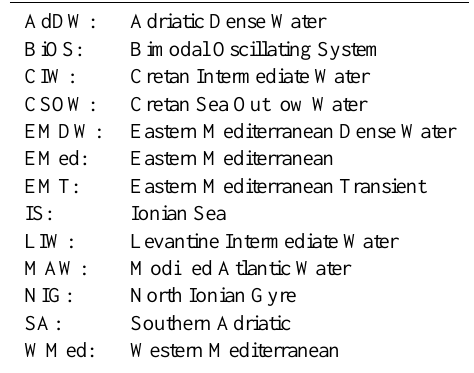
Table A1. List of